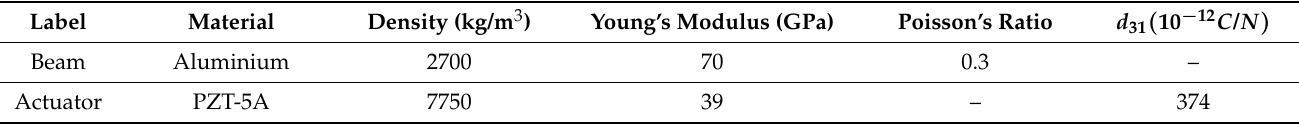
Table 3. PZT actuators and beam material